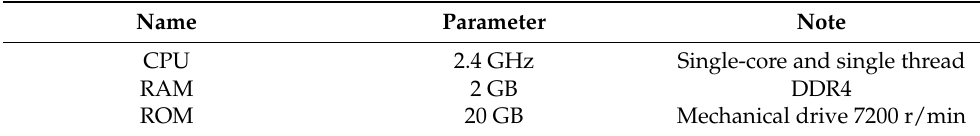
Table 2. Experimental environment parameter configuration.